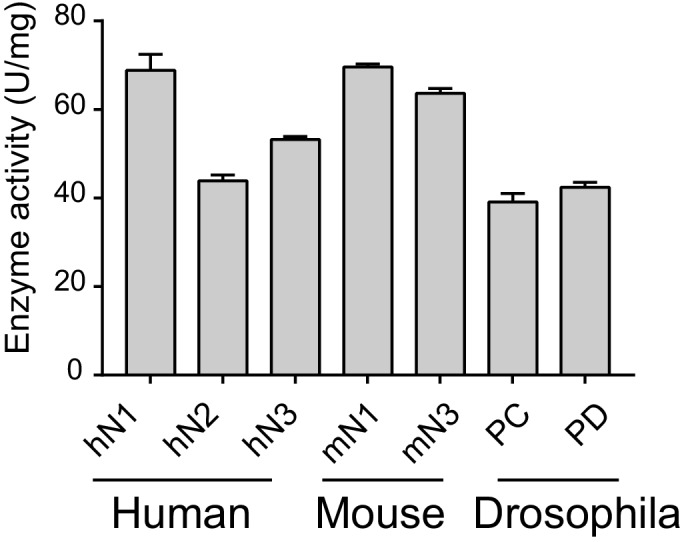
Enzyme activities of different isoforms of NMNAT from different organisms.The data shown correspond to mean ± s.d., with n = 3.